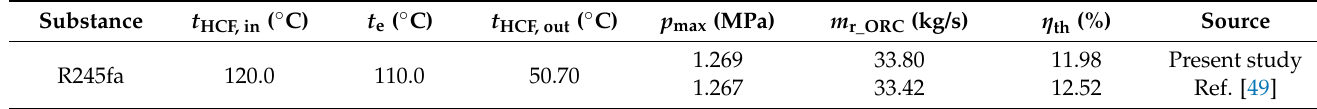
Table 2. Comparative results of ORC system between this paper and a previous